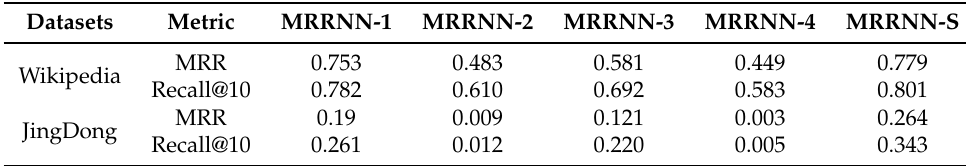
Table 4. Experiment result of the ablation